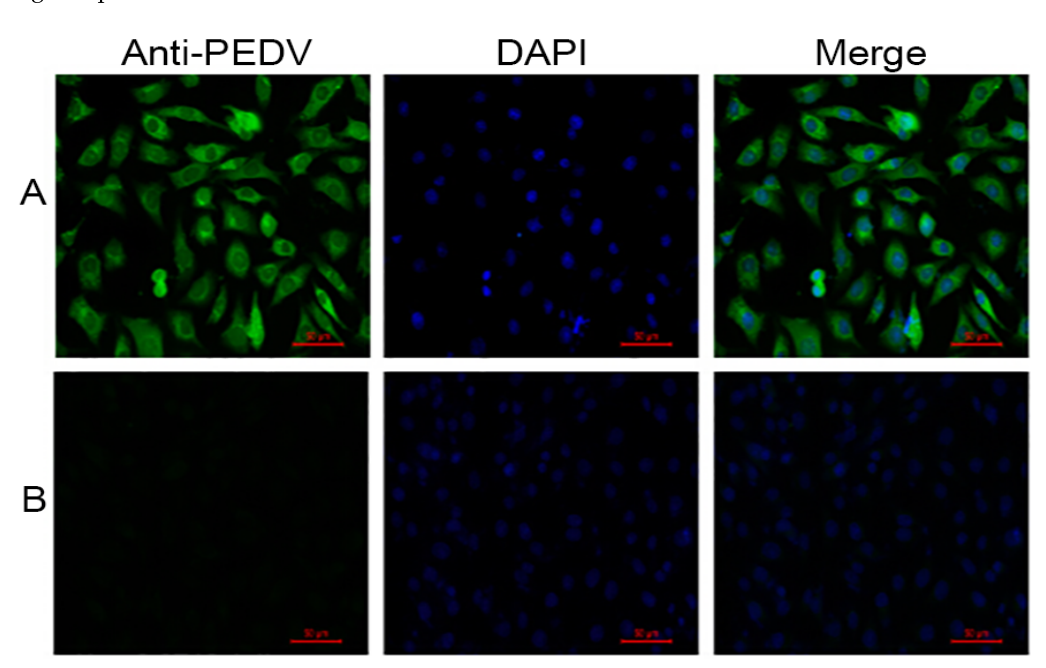
Figure 4. Detection of PEDV strain NJ in IECs by immunofluorescence assay at 24 h post-infection; mouse anti-PEDV S protein monoclonal antibody and fluorescein isothiocyanate (FITC)-conjugated goat anti-mouse immunoglobulin G (IgG) were respectively used as primary and secondary antibodies, followed by counterstaining with 4,6-diamidino-2-phenylindole (DAPI). ( A ) PEDV strain NJ-infected IECs; ( B ) Non-infected IECs.